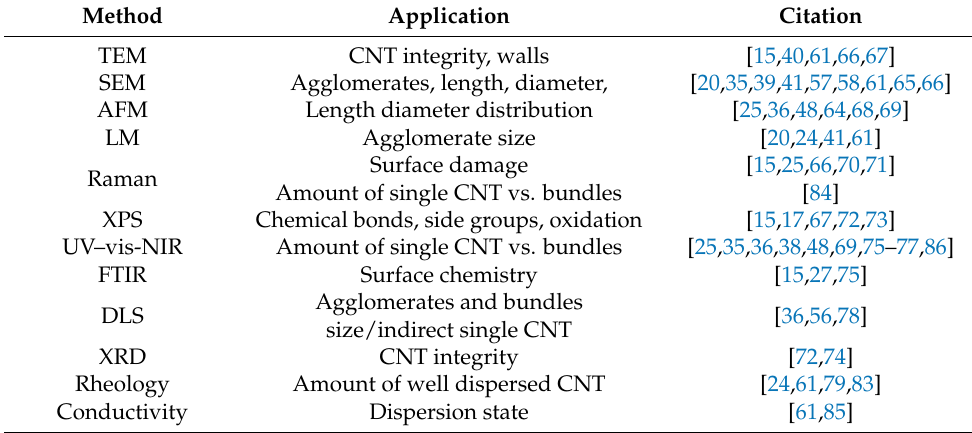
Table 1. Overview of methods for monitoring damage and dispersion